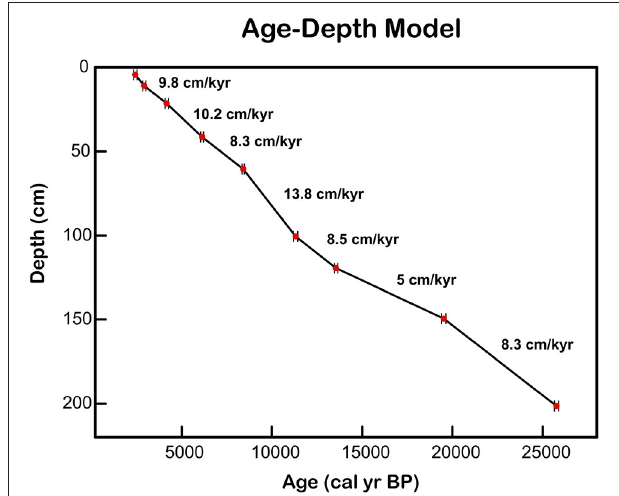
FIGURE 2 | Age-depth model of AMS dates of foraminifers at selected depth of the sediment core SK-304A/05. Linear interpolation of sedimentation rates is assumed based on the AMS